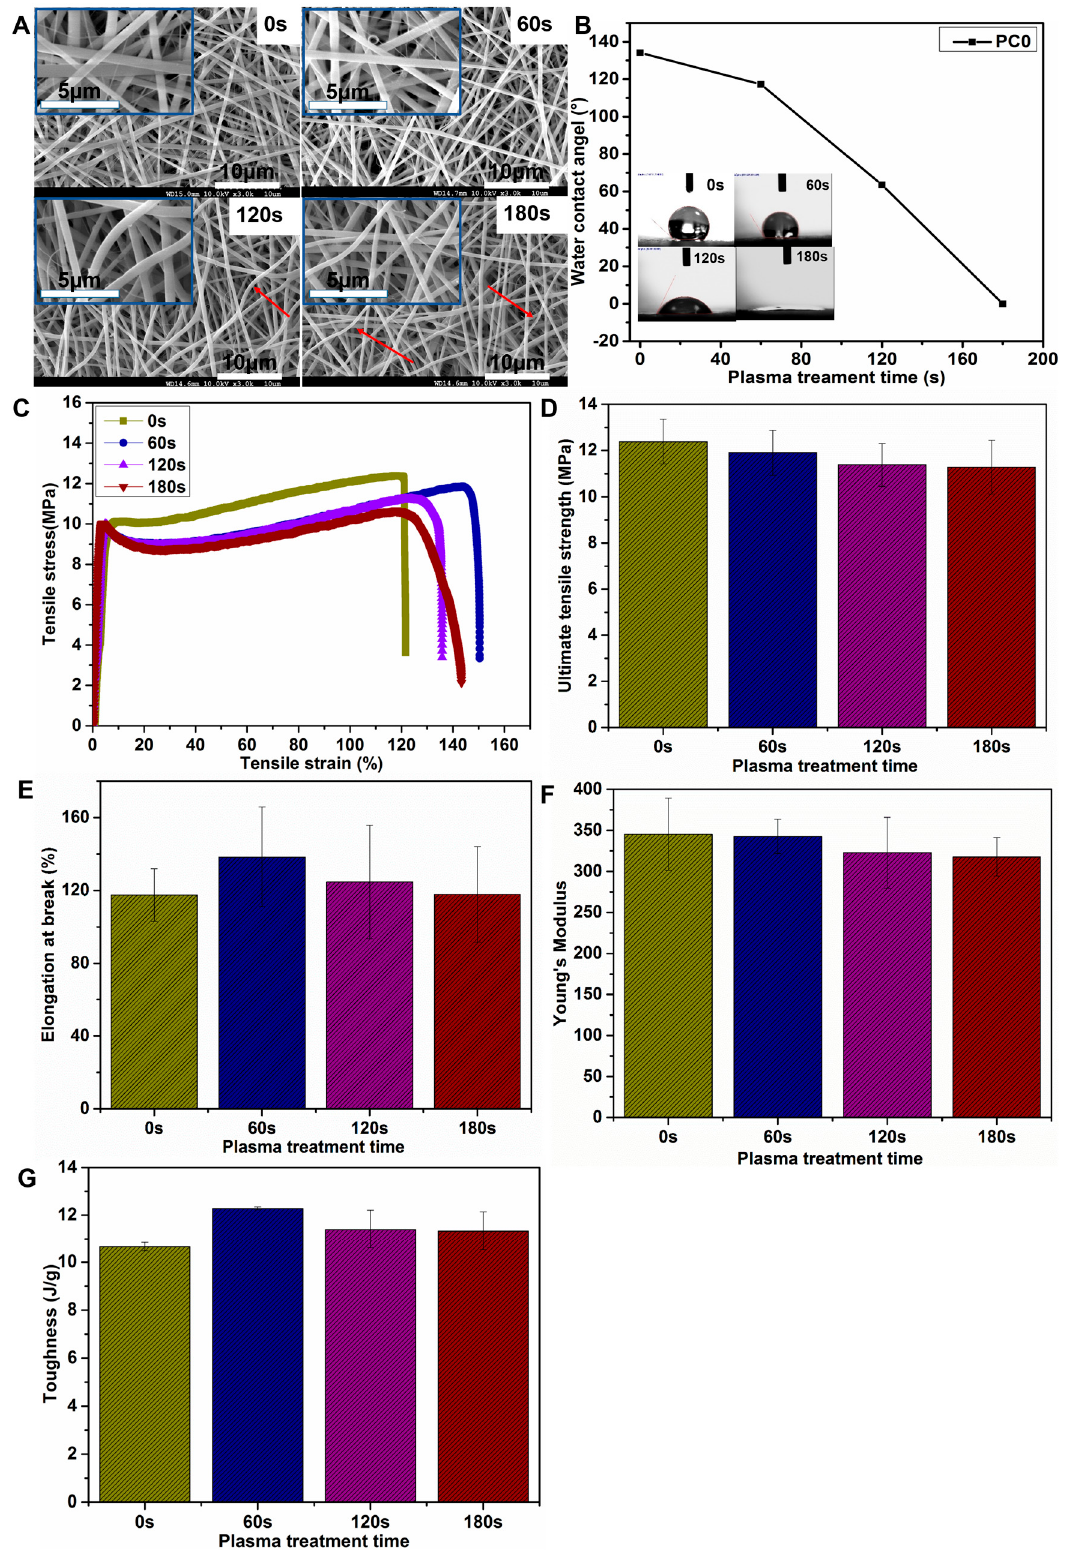
Figure 5. ( A ) SEM images and ( B ) water contact angles of PC0 nanofibers after a plasma treatment time of 0, 60, 120, and 180 s; ( C ) The tensile stress-strain curves of PC0 nanofibers with various plasma treatment duration, and ( D ) calculated ultimate tensile strength, ( E ) elongation at break, ( F ) Young’s modulus and ( G ) toughness.